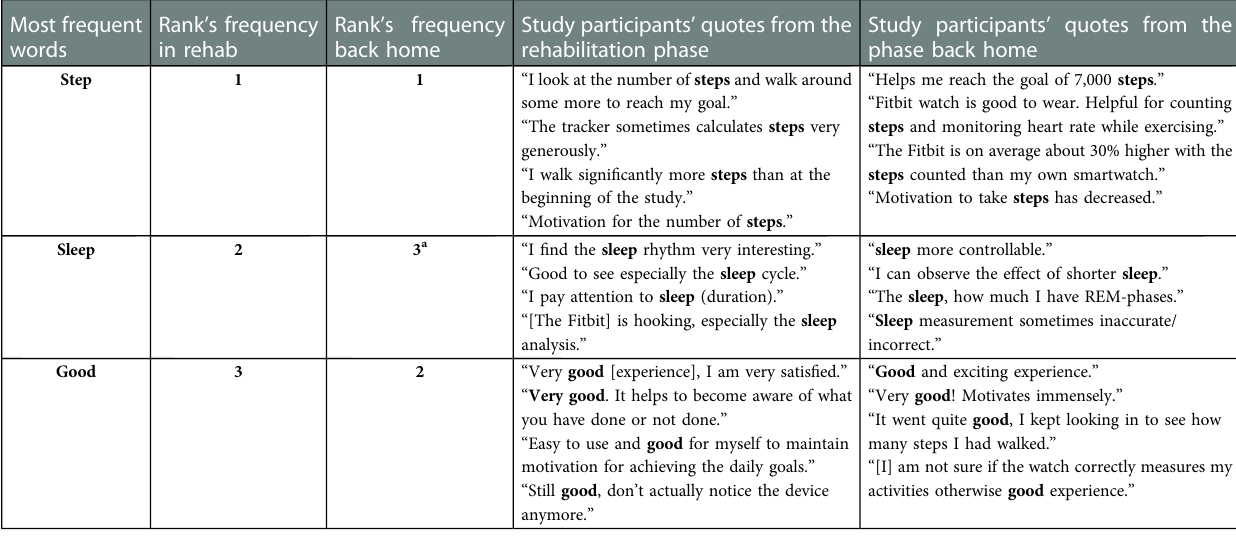
TABLE 3 The three most frequent keywords used by the study participants in the answers given during the rehabilitation phase or the phase back home to the question “ what was your experience with activity trackers this week? ” together with answer extracts. Most frequent words